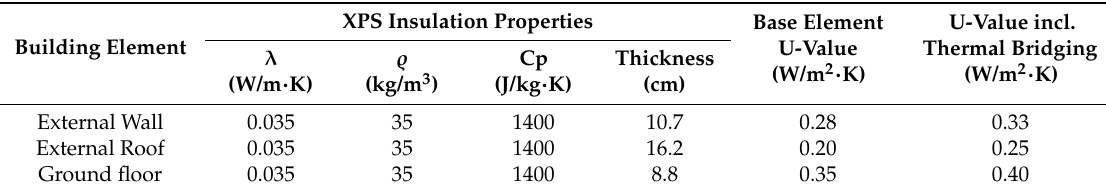
Table 3. Detailed information on building envelope element insulation.